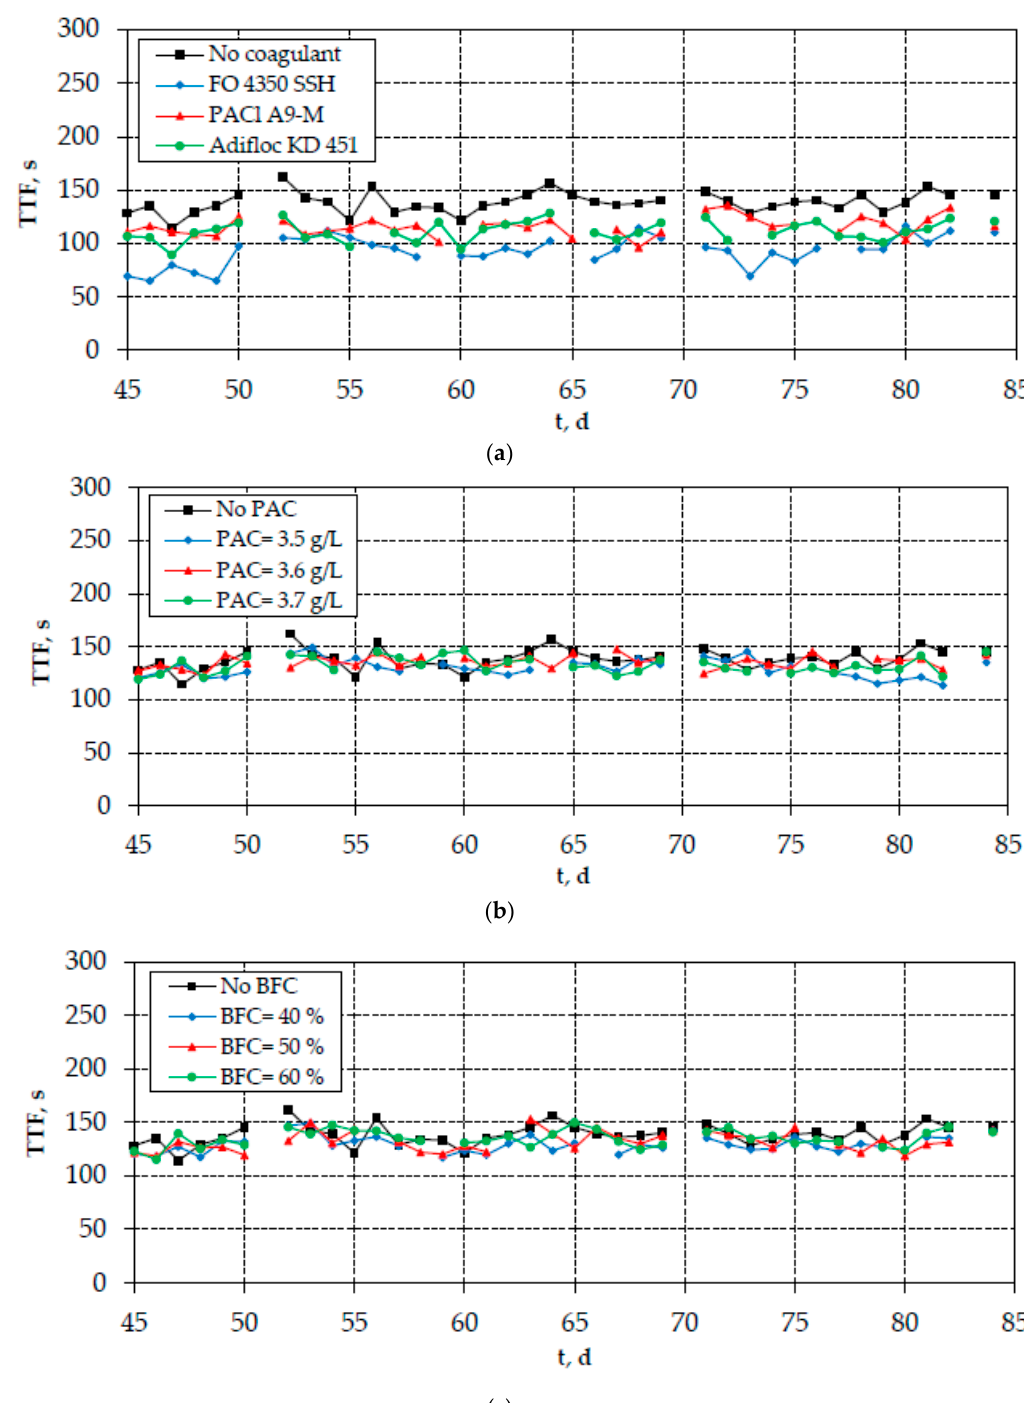
Figure 5. Evolution of TTF in the mixed liquor after the addition of (a) optimal coagulation agents FO 4350 SSH (10 mg/L), PACl A9-M (100 mg Al/L), and Adifloc KD 451 (10 mg/L); (b) optimal PAC concentrations (3.5–3.7 g/L), and (c) bio-film carriers (40%, 50%, and 60%).